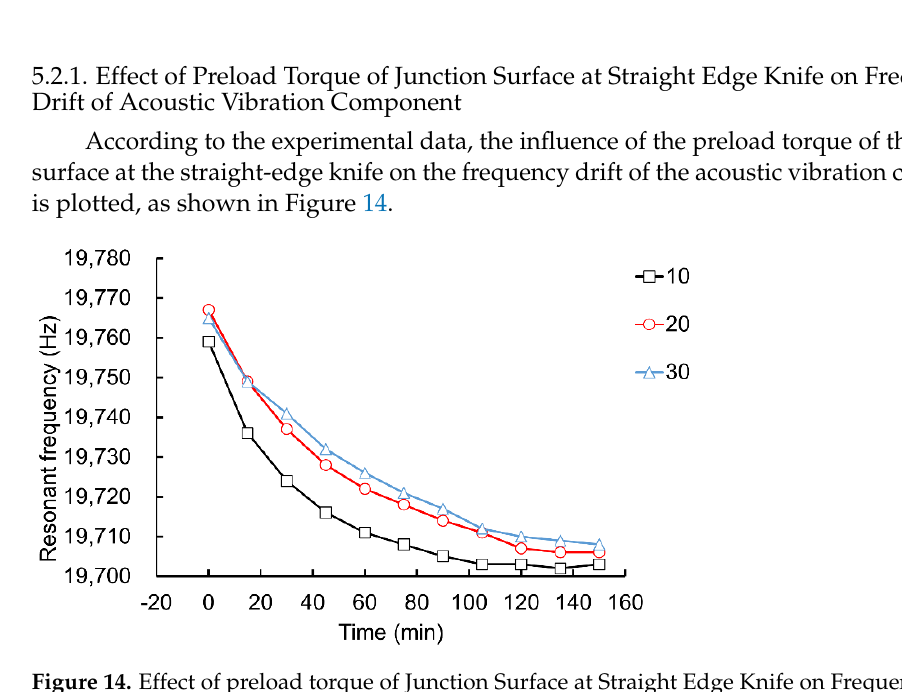
Figure 14. Effect of preload torque of Junction Surface at Straight Edge Knife on Frequency Drift of Acoustic Vibration Component.